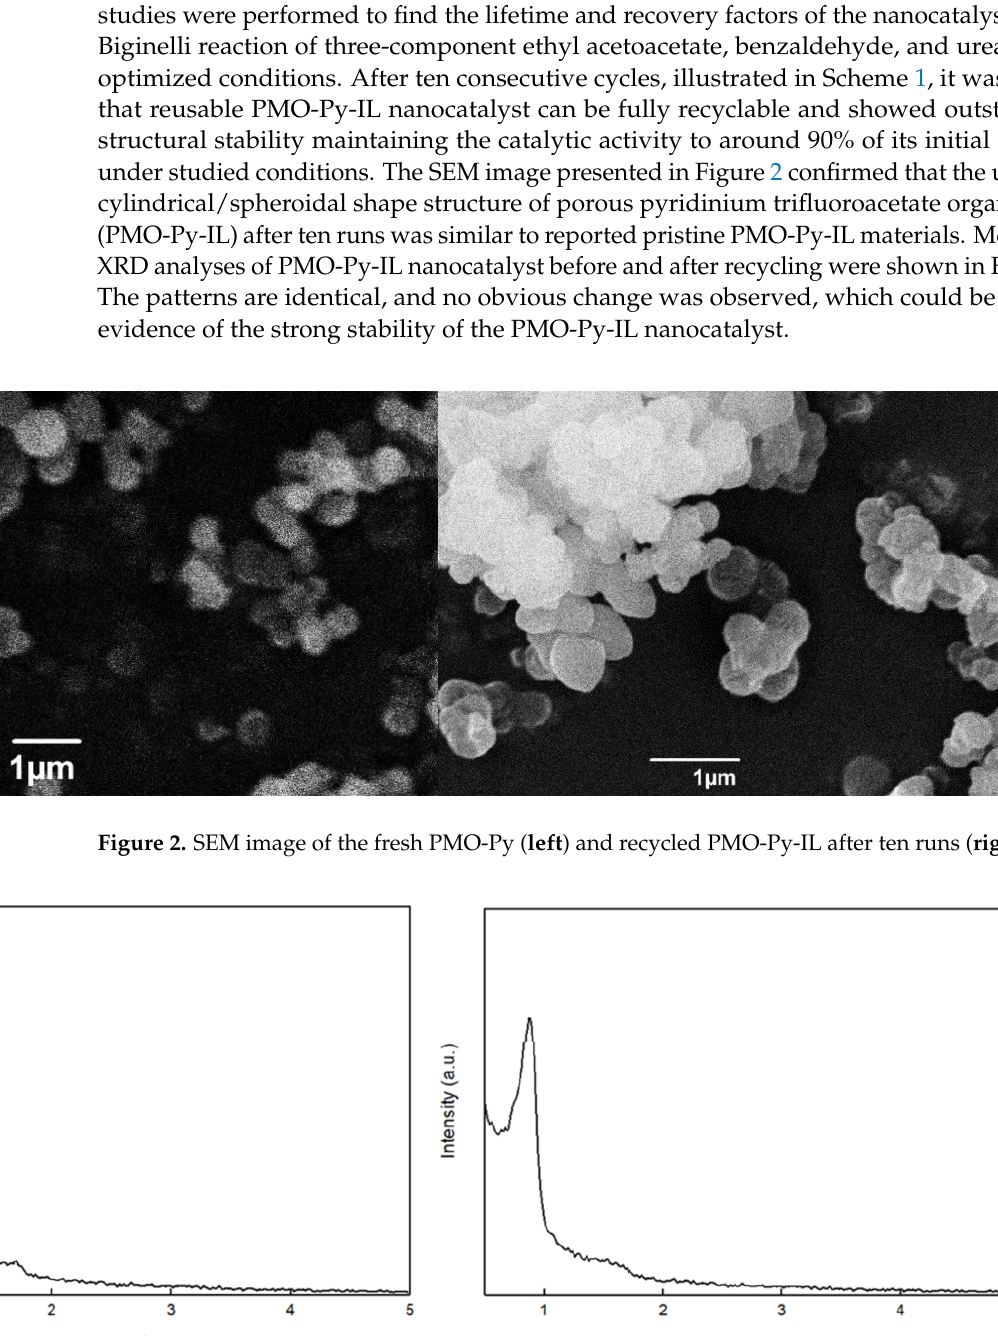
Figure 3. XRD patterns corresponding to the fresh PMO-Py-IL ( left ) and recycled PMO-Py-IL after ten runs ( right ).